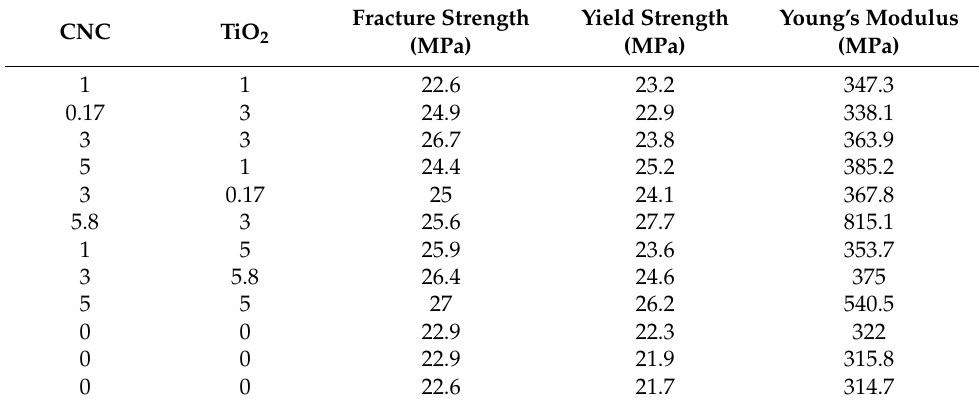
Table 2. The mean mechanical properties of the developed HDPE nanobiocomposites.